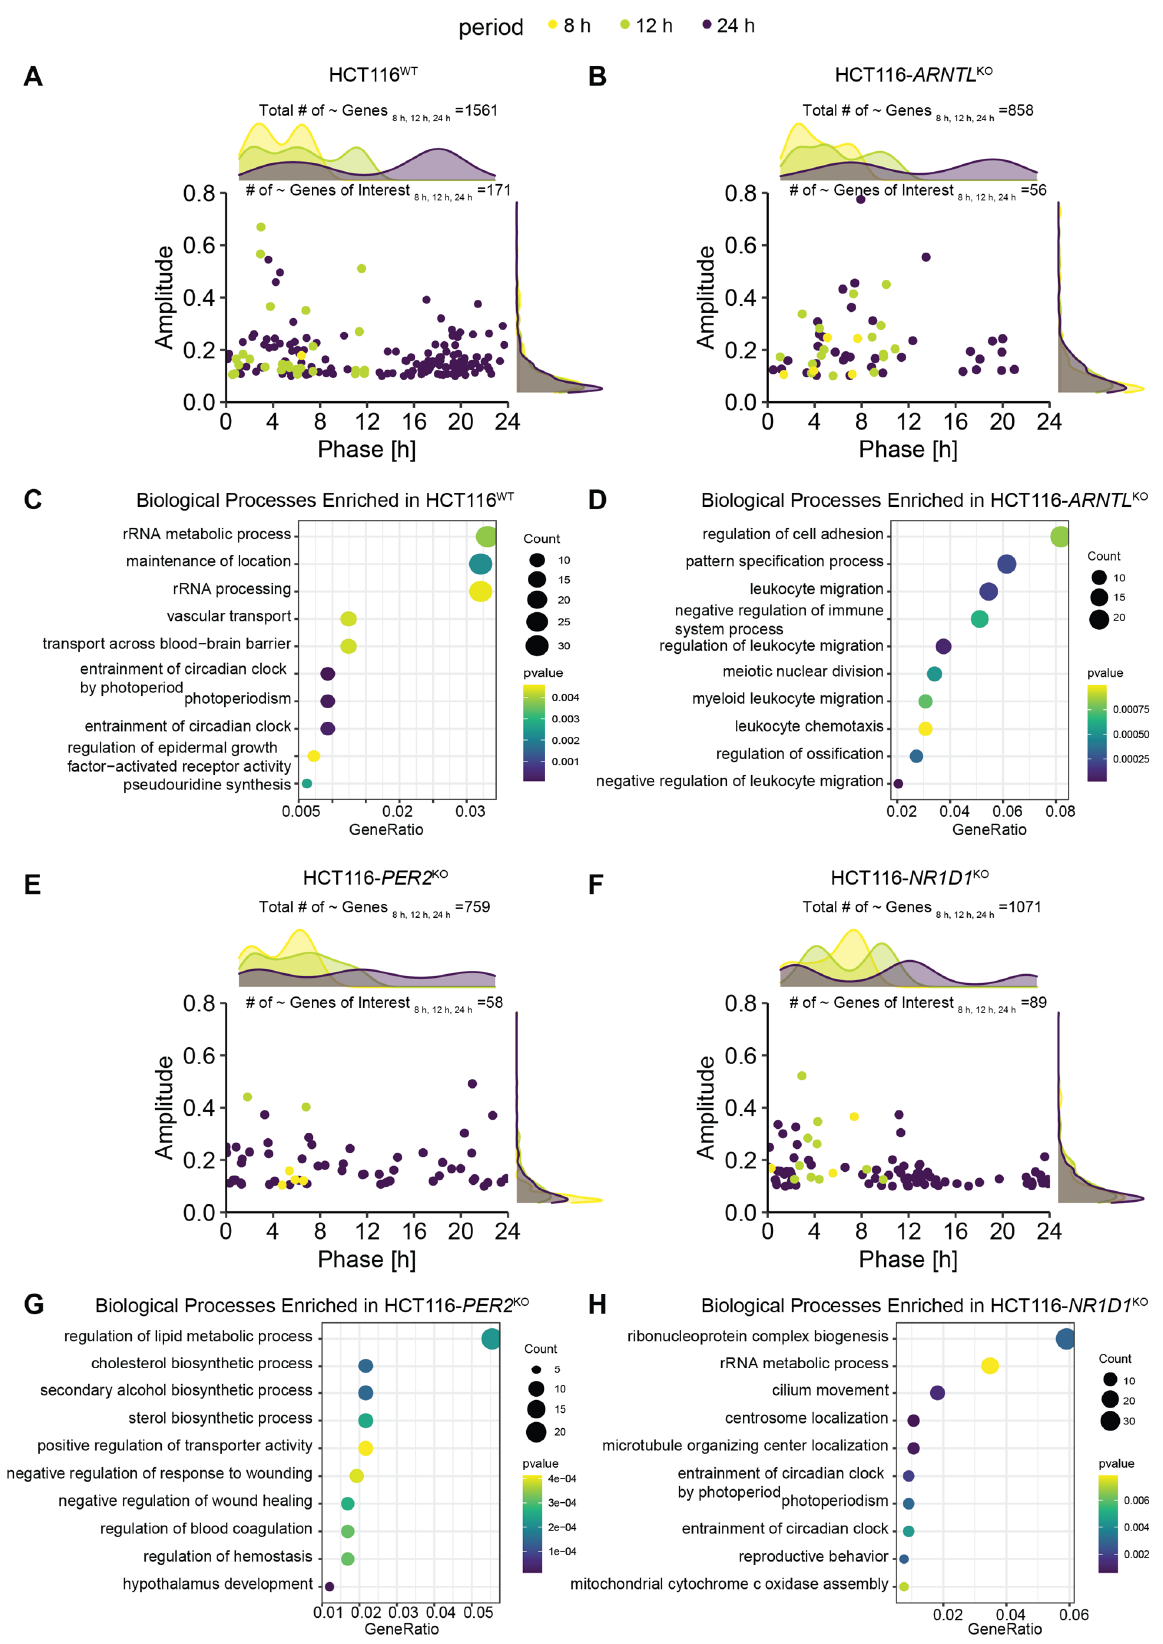
Figure 2. Core-clock KO affects the rhythmic characteristics of expressed genes in HCT116 cells and the associated